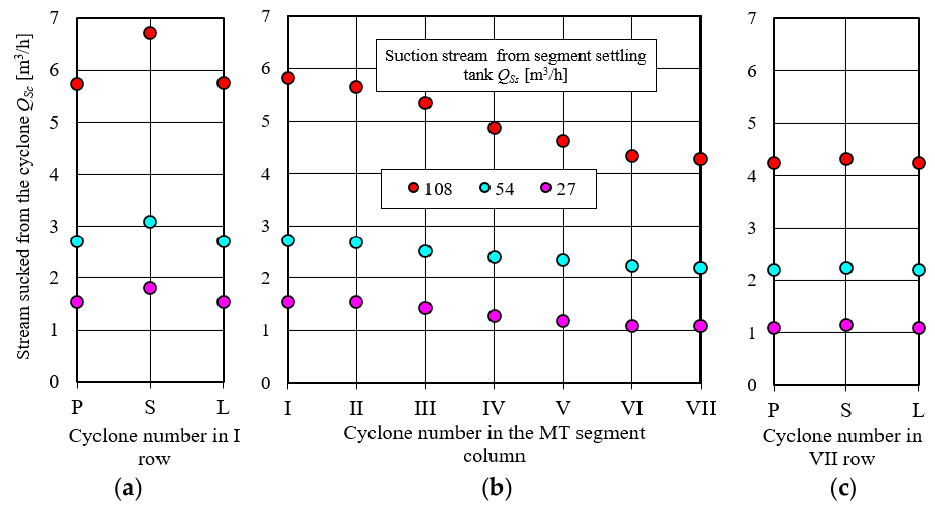
Figure 18. Q Sc values sucked off streams from single cyclones of the original S MT segment: ( a ) in the row No. I, ( b ) in the left column (L), ( c ) in the row No. VII.